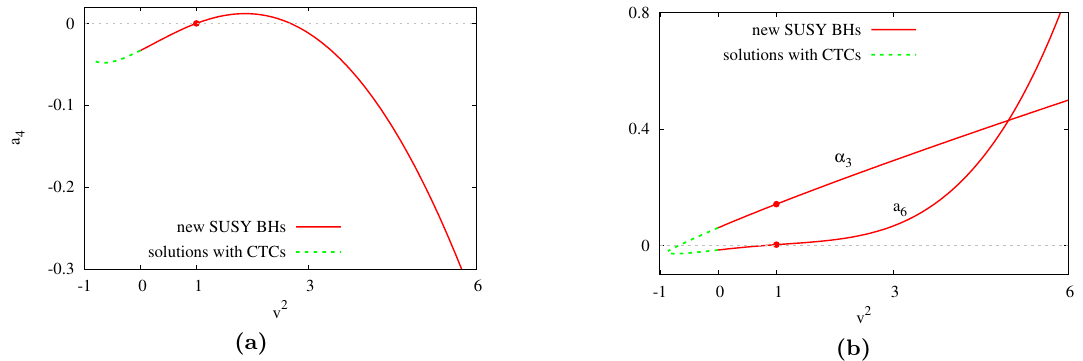
Figure 14. (a) The large- (cid:26) expansion parameter a 4 as a function of the squashing v . (b) A similar (cid:12)gure for the parameters a 6 and (cid:11) 3